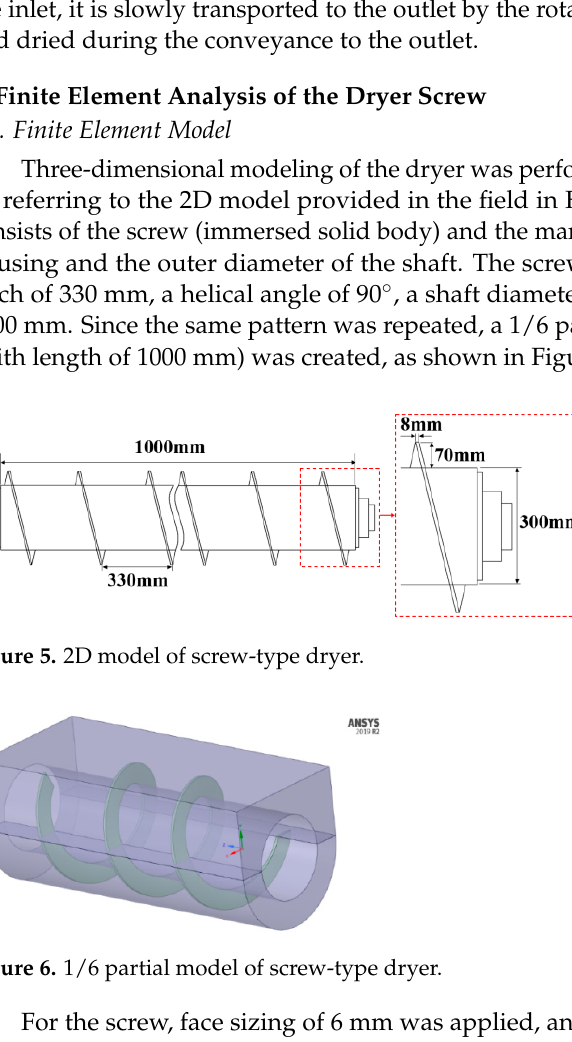
Figure 4. Structure of screw-type dryer.